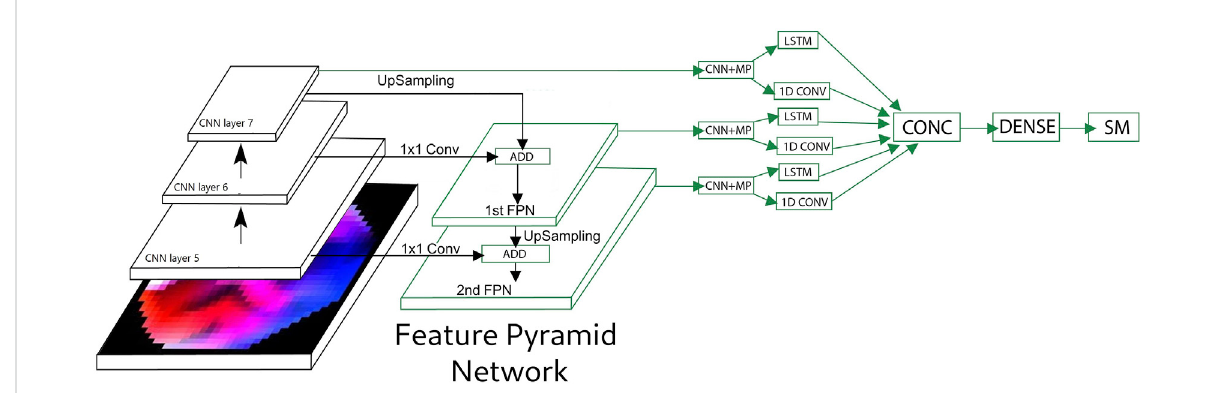
FIGURE 5 Feature pyramid network (FPN) and long – short term memory (LSTM) network for the EEG video. CNN, convolution neural network; MP, maxpool; CONC, concatenate; SM,